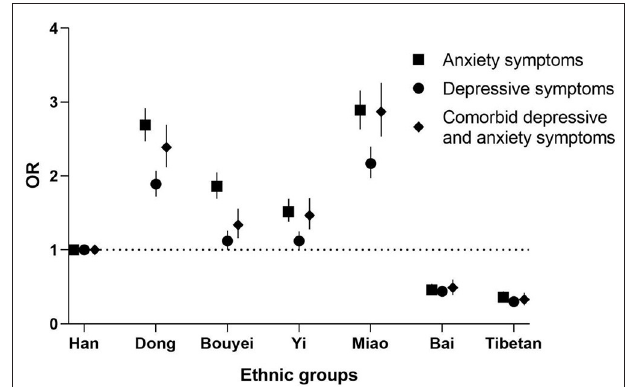
FIGURE 2 | Odds ratios of depressive symptoms, anxiety symptoms, and comorbidity by minority groups compared with Han nationality. Each closed square, circle or rhombus represents an odds ratio, and the horizontal lines represent the 95% confidence interval (CI). All odds ratios were adjusted for age, sex, marriage, education level, occupation, family income, smoking, alcohol consumption, tea consumption, BMI, and physical